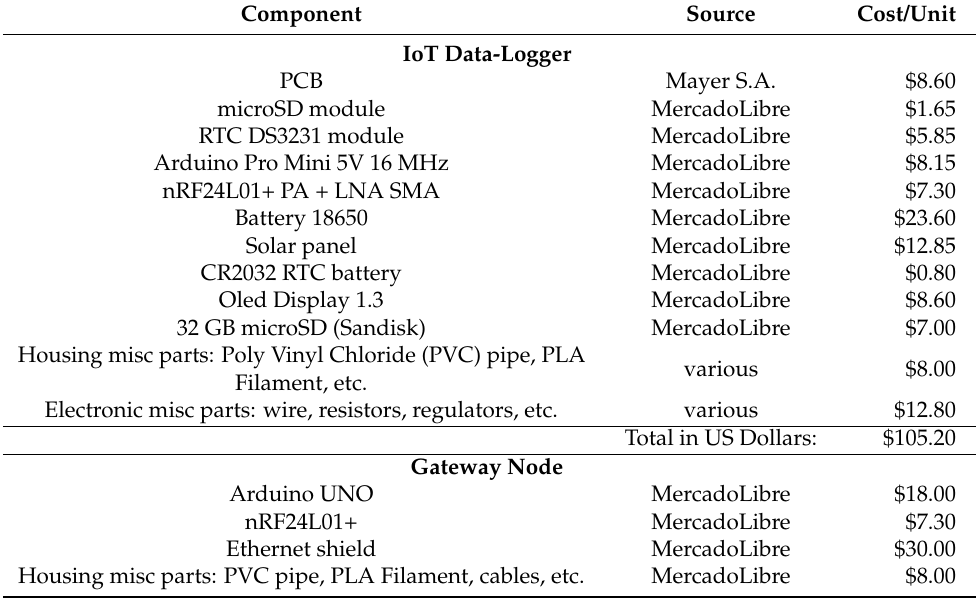
Table A1. Components and price list for IoT device, the water table probe and soil moisture sensor. Prices are based on delivery to Santa Fe, Argentina. Items without a suggested supplier are generally available at electronics retailers or hardware